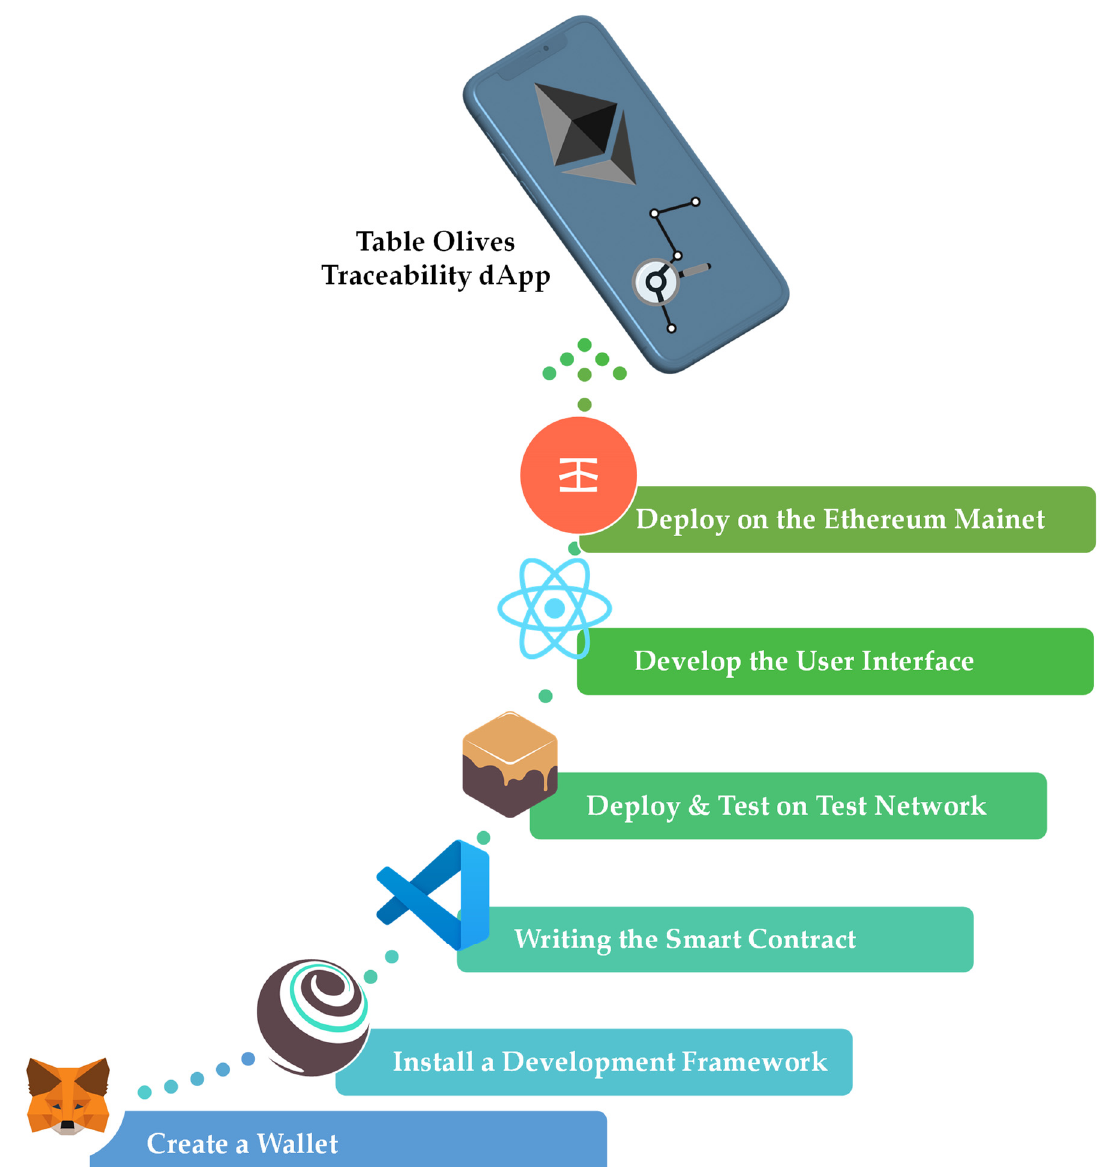
Figure 2. Methodology for Developing an Ethereum-based Distributed Application.